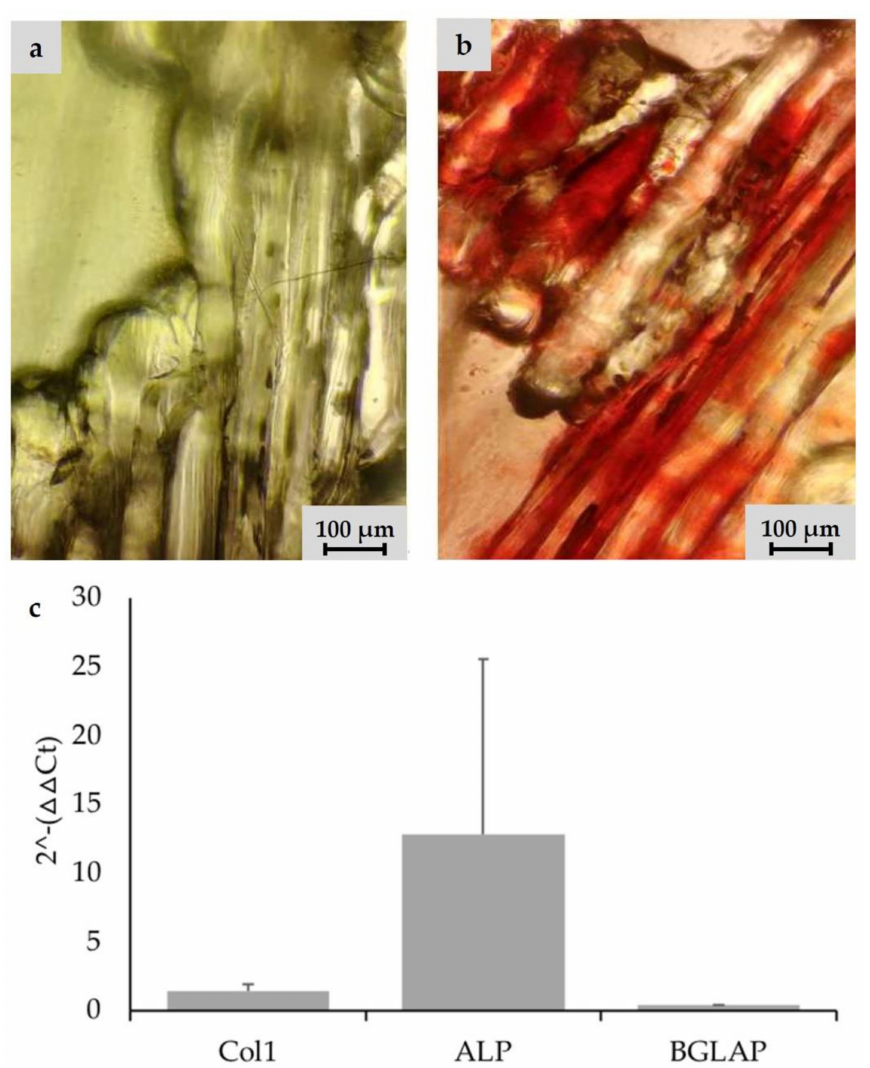
Figure 4. Detection of calcium deposition via alizarin staining on undyed sca ff old prototype coated with Saos-2 cells after 21 days: ( a ) left sca ff old was seeded in RPMI-medium; ( b ) right sca ff old was incubated with osteogenic di ff erentiation medium; and ( c ) PCR results for osteogenic di ff erentiation on Day 21. Saos-2 cells seeded on sca ff olds were incubated with RPMI medium and osteogenic di ff erentiation medium. Focus was on cDNA for osteogenic proteins: collagen 1 (Col1), alkalic phosphatase (ALP), and osteocalcin (BGLAP). GAPDH was used as internal standard. The 2 − ( ∆∆ Ct) values are